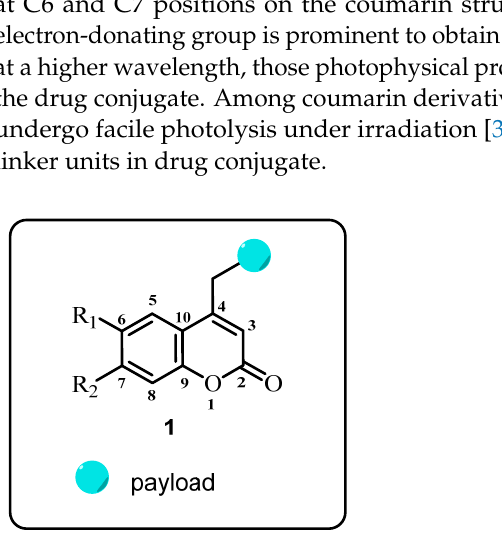
Figure 3. The structures of coumarin derivatives as linker in drug conjugate.